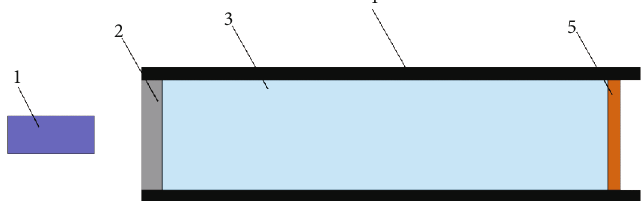
Figure 4: Schematic of the water tube experimental set-up. 1-Steel projectile; 2-Al piston; 3-water; 4-steel tube; 5-test specimen.